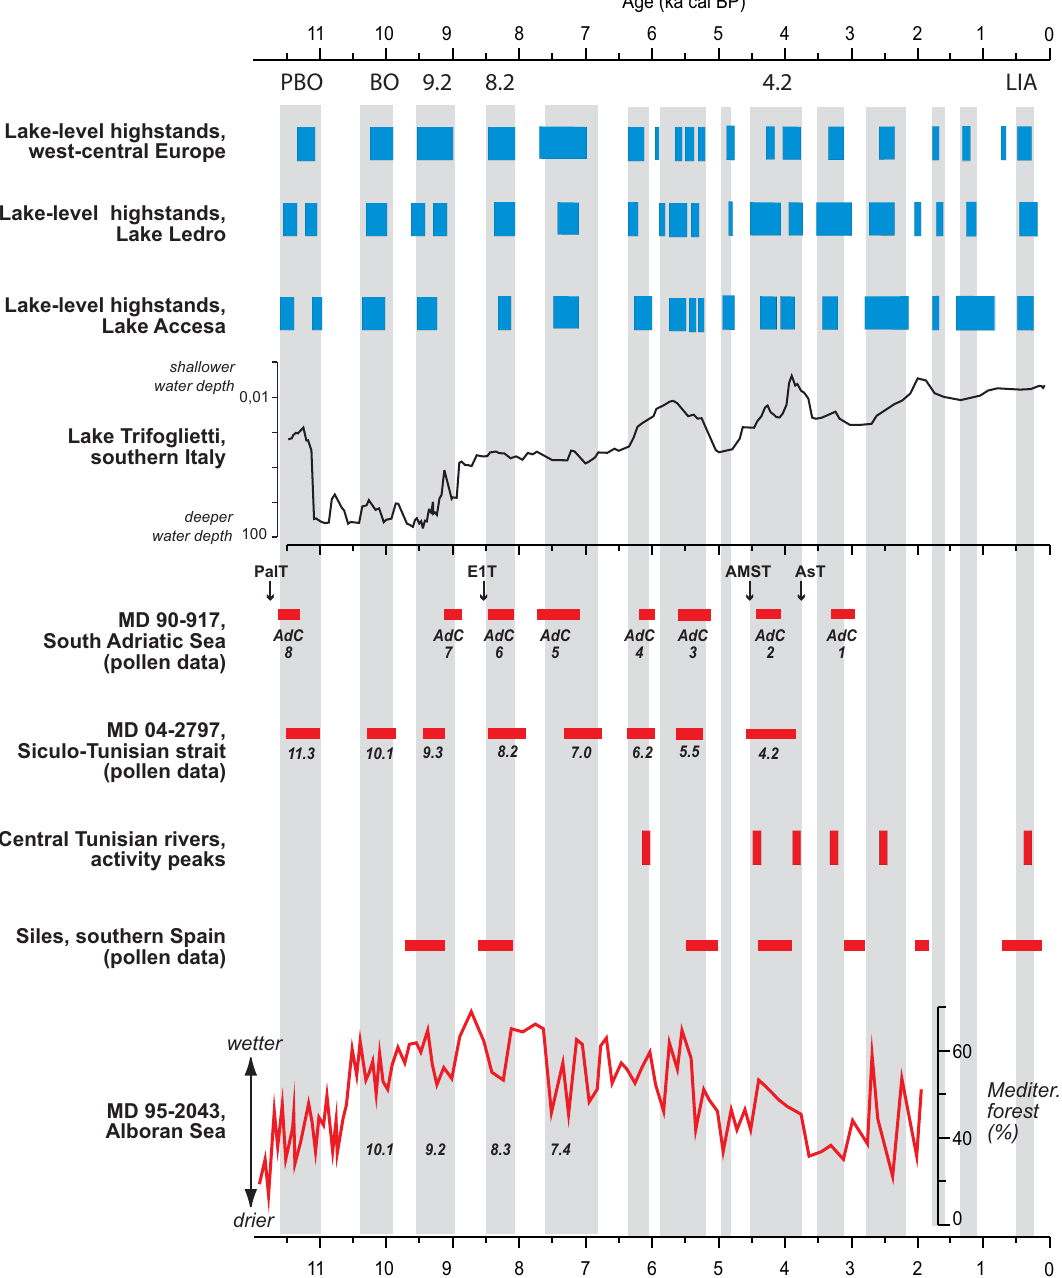
Fig. 5. Comparison between centennial-scale variations in humidity as reflected by lake-level, fluvial, and pollen records in west-central Europe and in the north- and south-western Mediterranean. To the north, wetter climatic conditions are marked by lake-level highstands (blue boxes) reconstructed for west-central Europe (Magny, 2004, 2006, 2013), Lake Ledro (Magny et al., 2012b), Lake Accesa (Magny et al., 2007), and Lake Trifoglietti (Joannin et al., 2013). To the south, dry phases (red boxes) are marked for activity peaks of Central Tunisian rivers (Ziehlhofer and Faust, 2008); pollen data at Siles (Carri´on, 2002); and marine cores MD 90-917 (Combourieu Nebout et al., 2013), MD04-2797 (Desprat et al., 2013) and MD95-2043 (Fletcher et al., 2013). PBO: Preboreal oscillation; BO: Boreal oscillation; LIA: Little Ice Age. For the MD90-917 record, the labels PalT, E1T, AMST and AsT correspond to the Palinuro, E1, Agnano–Monte Spina and Astroni tephras,